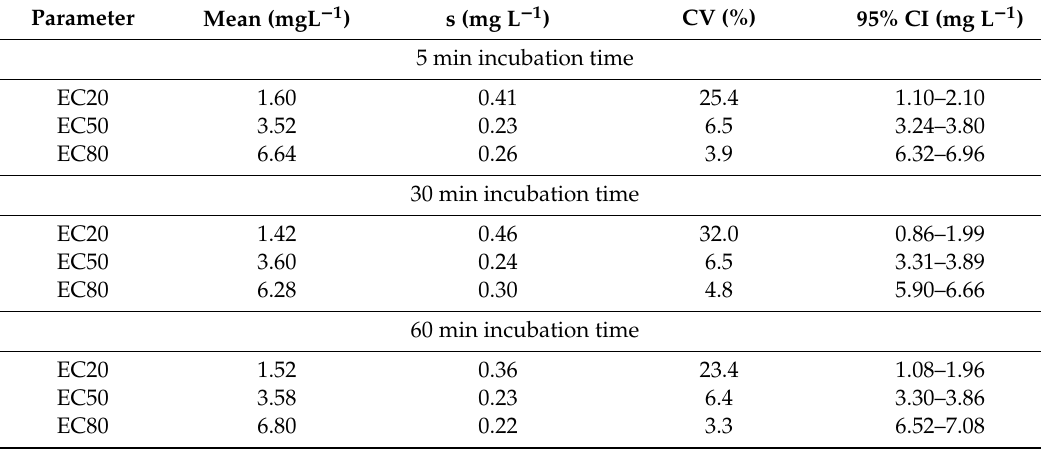
Table 2. Toxicity of 3.5-dichlorphenol at di ff erent incubation times, as determined by the modified method. The experiments served for evaluating the influence of the incubation time on EC values and as a comparison of the EC values with the standard procedure. The number of repetitions was five. s = standard deviation, CV = variation coe ffi cient and CI = confidence